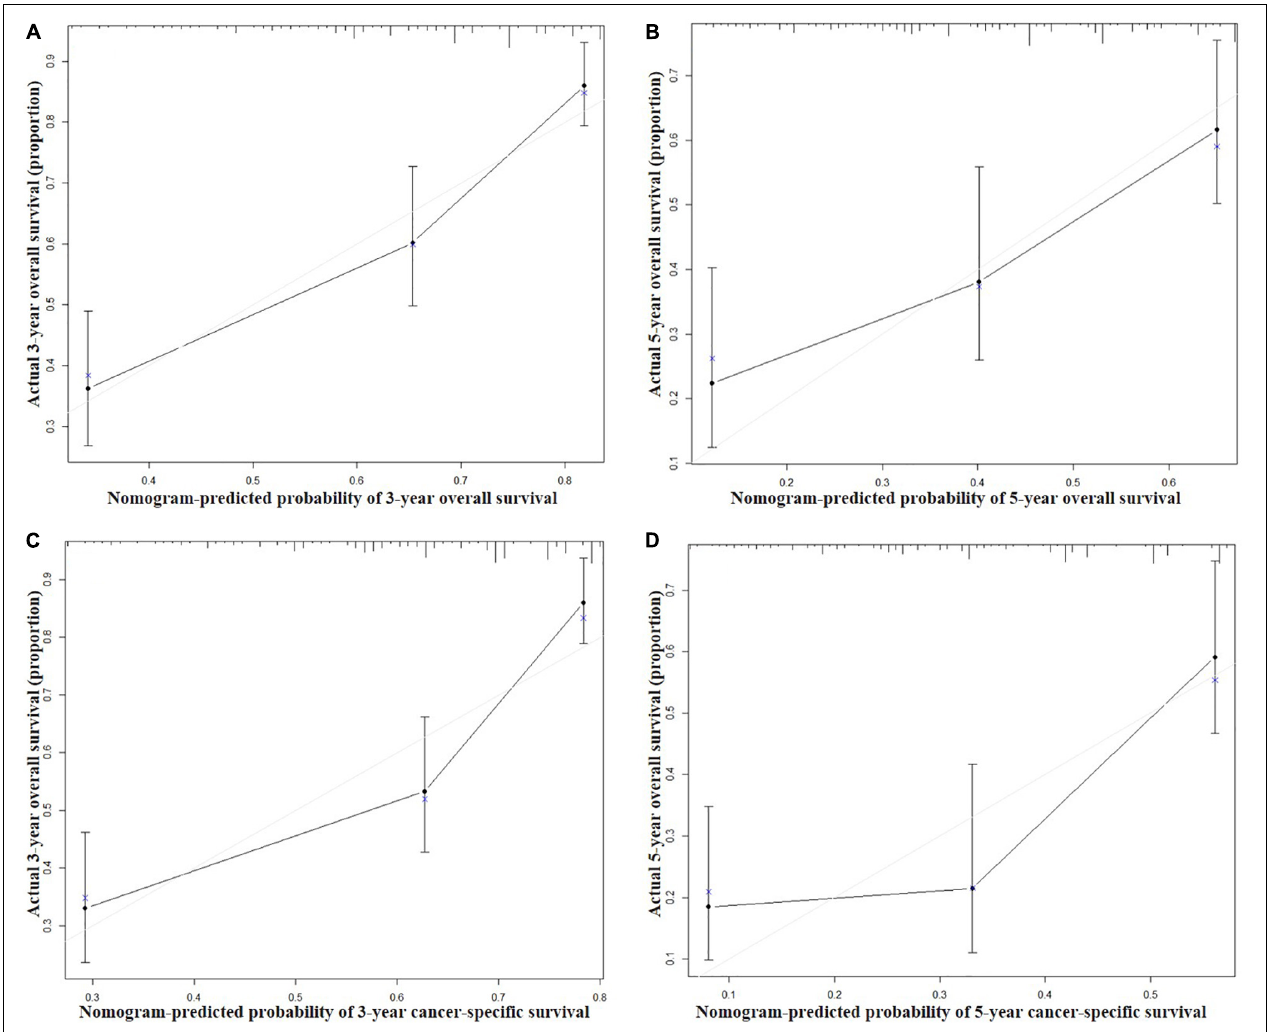
FIGURE 3 | Calibration curves for 3-year (A) and 5-year (B) overall survival; and 3-year (C) and 5-year (D) cancer-specific survival in the training set. The X axis represents the nomogram predicted survival rate, whereas the Y axis represents the actual survival